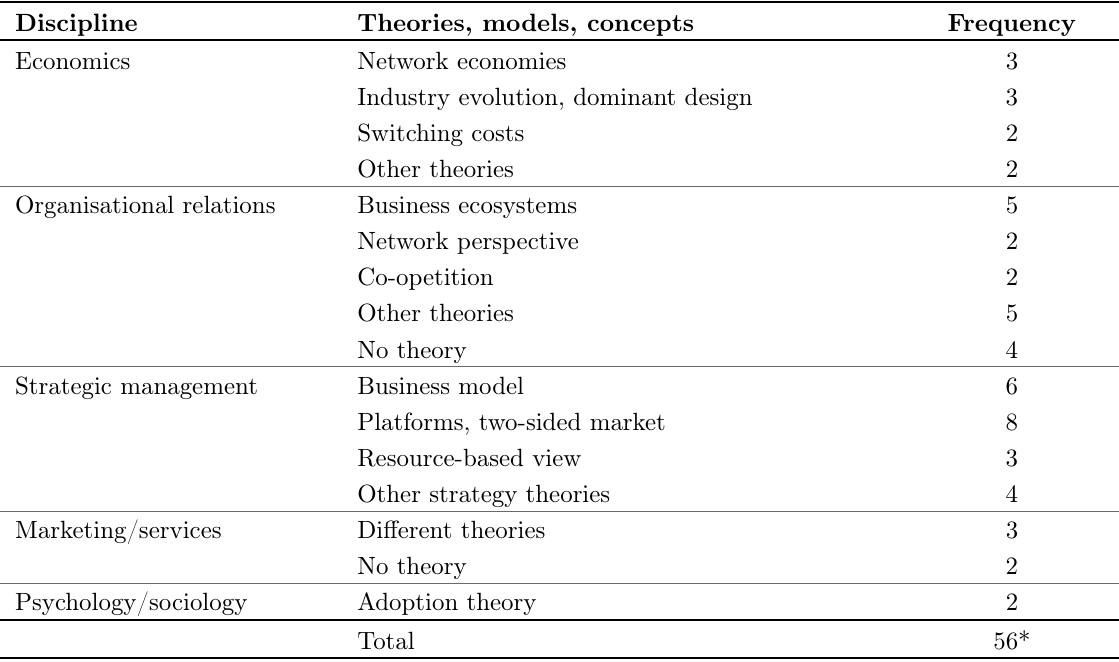
Table 17. Theoretical base used in research on business aspects of mobile payments.